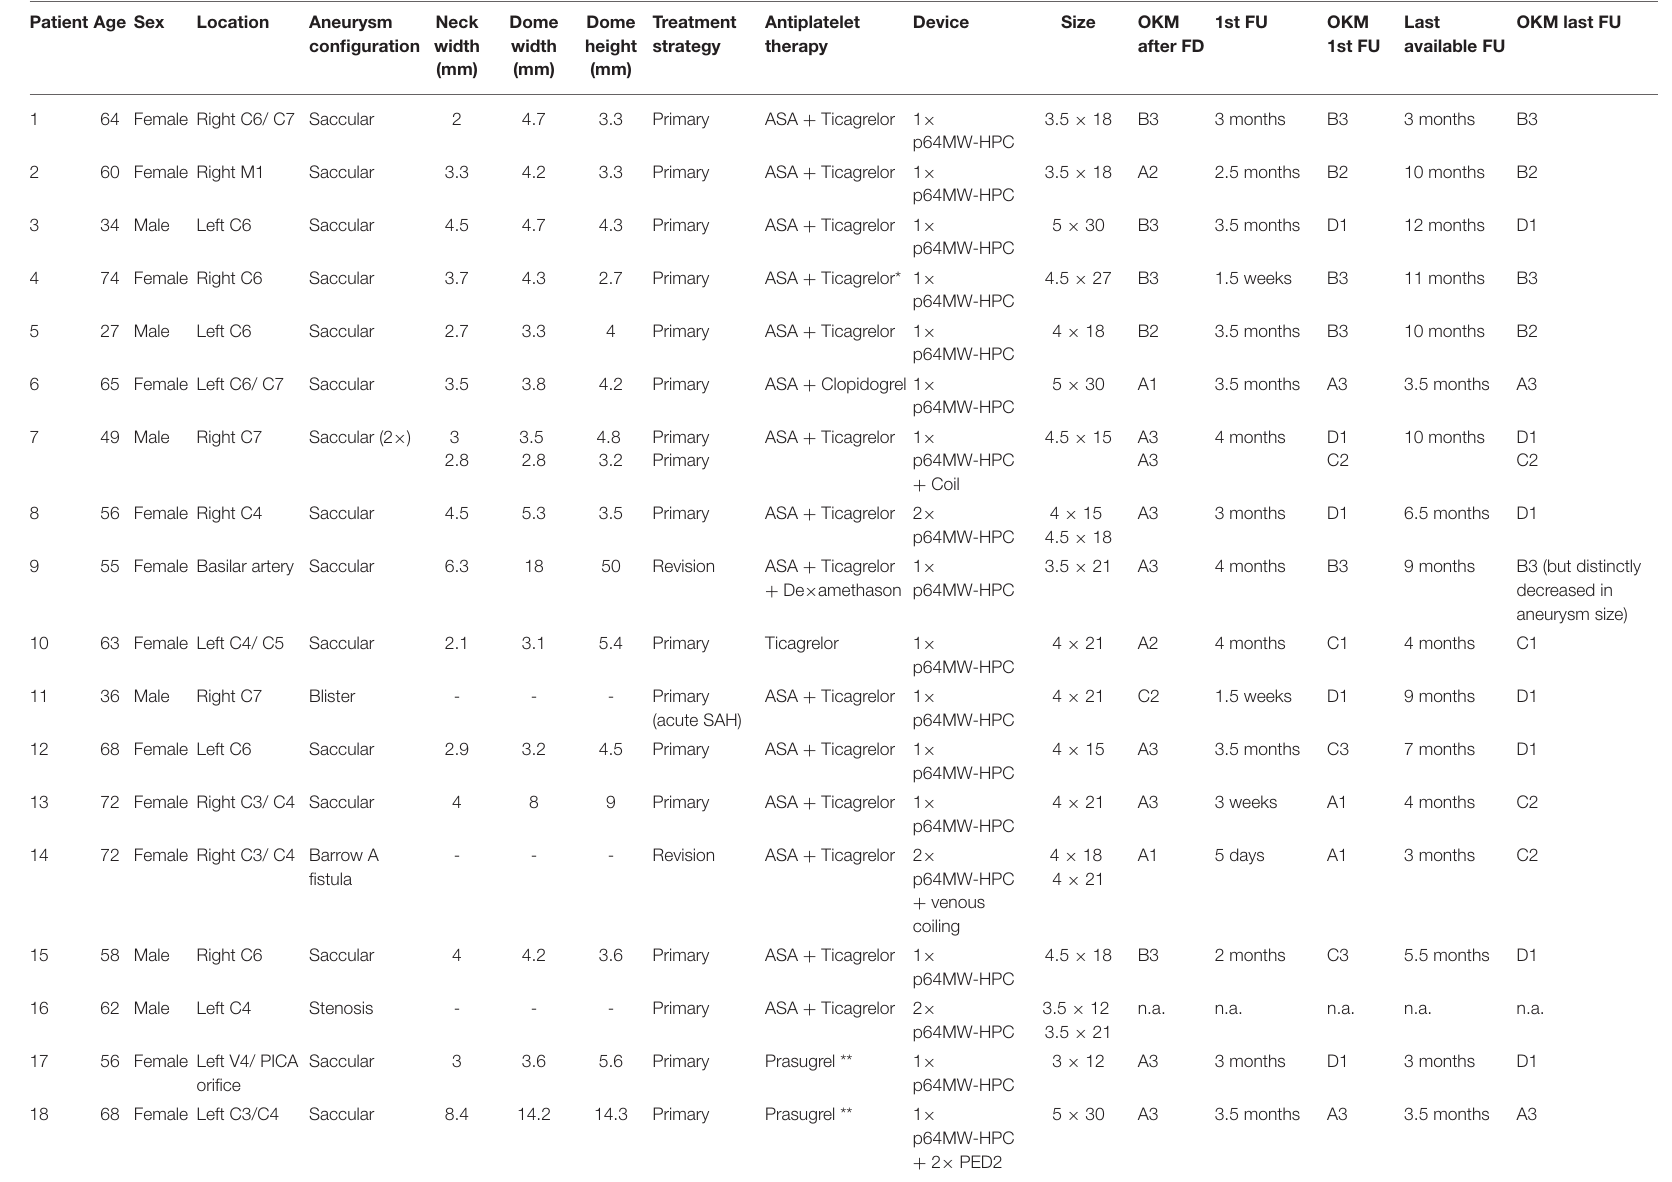
TABLE 1 | Demographic